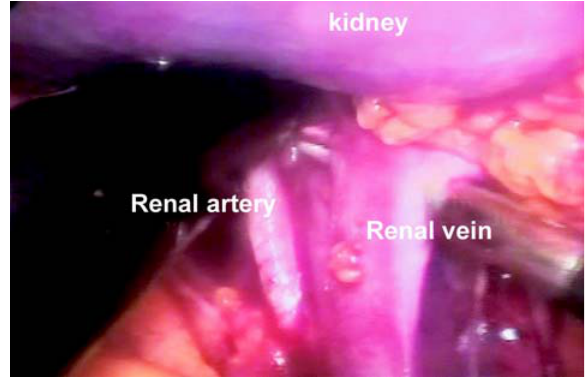
Figure 9 – Dissection of the renal vessels by retroperitoneoscopy.